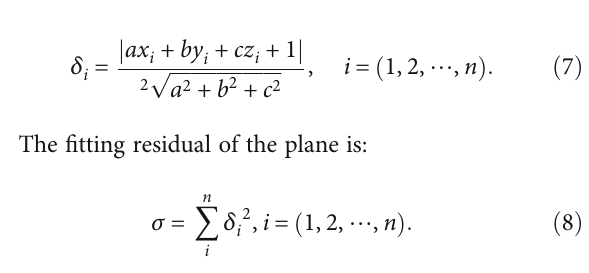
Figure 3: Display fl ow of three-dimensional